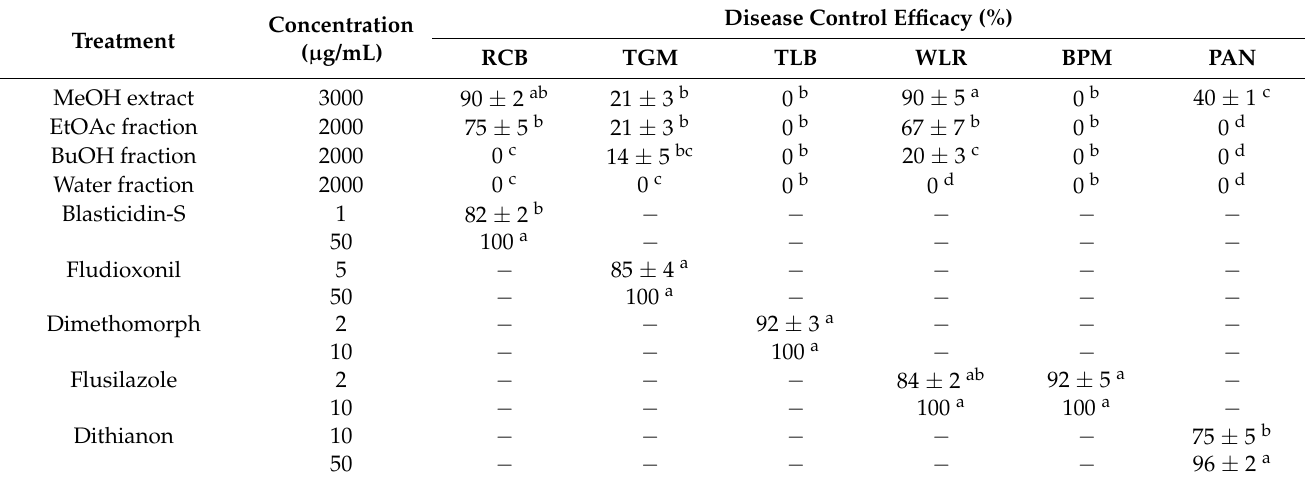
The values represent the mean ± standard deviation of two runs with three replicates. Values with different letters are significantly different at p < 0.01 according to Duncan’s multiple range test. RCB, rice blast; TGM, tomato gray mold; TLB, tomato late blight; WLR, wheat leaf rust; BPM, barley powdery mildew; and PAN, pepper anthracnose. –, not